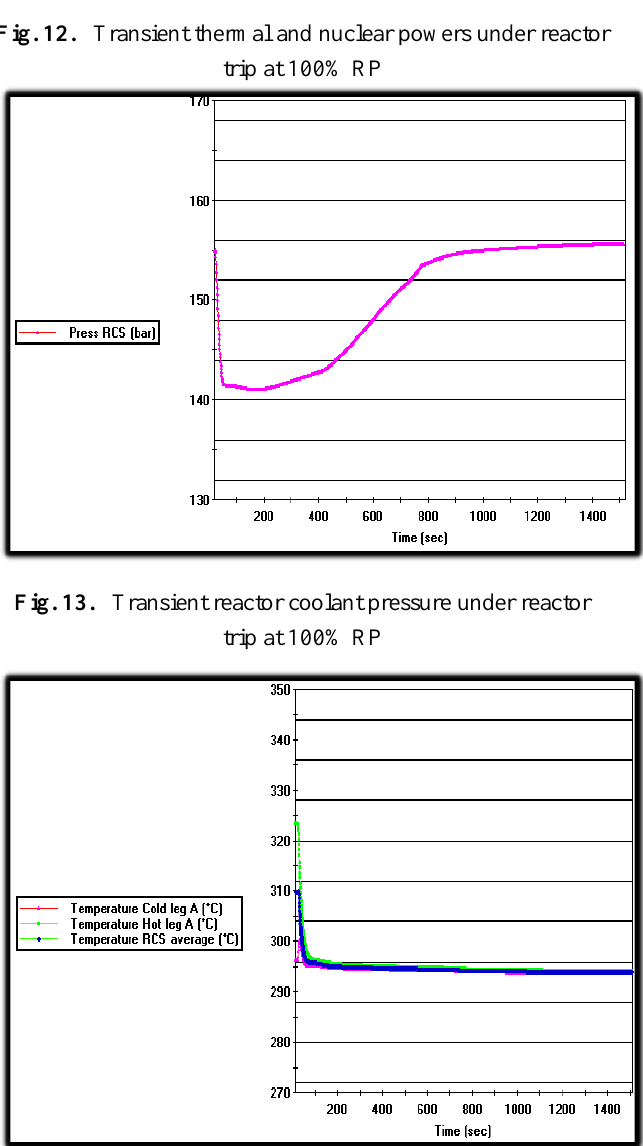
Fig. 14. Transient reactor coolant temperatures under reactor trip at 100%